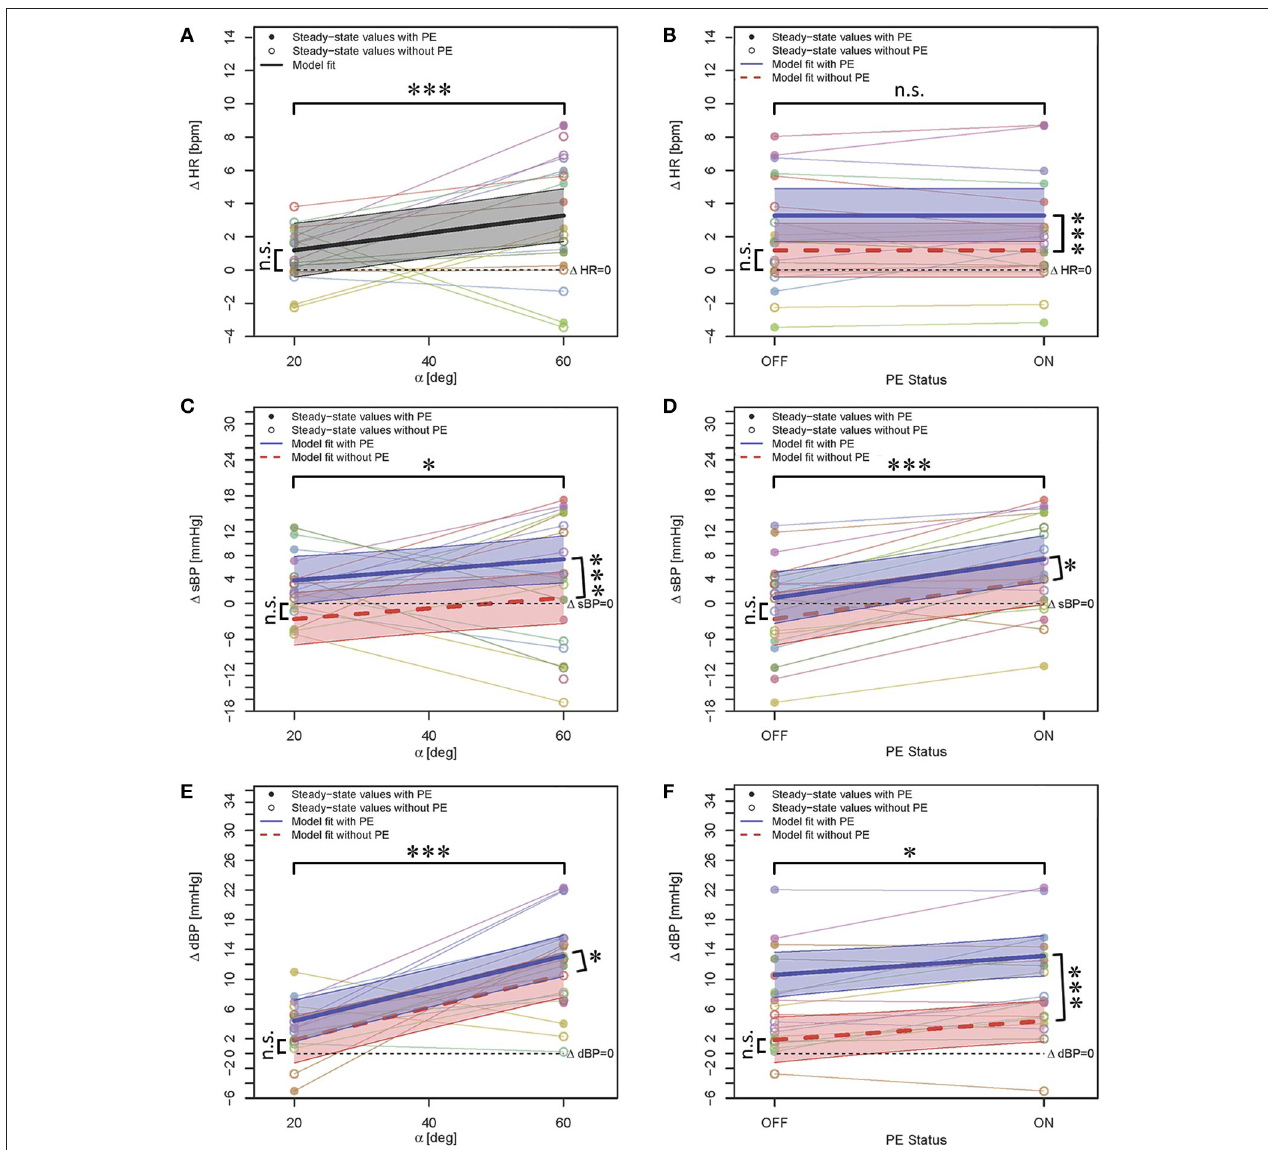
FIGURE 4 | Statistical models for 1 HR (A,B), 1 sBP (C,D) , and 1 dBP (E,F) responses to PE when the effect is considered together with the effect of head-up tilting. In this figure, both columns show the same models with variation with respect to tilt angle (left column) and PE status (right column), respectively. As the PE effect for 1 HR was not significant, Figure 4A , only shows one model for both conditions of with and without PE. Data points correspond to the average of steady-state response on two days. In case of availability of only single case measurement, the data point without averaging is shown. The steady-state values for each subject in each case (PE status or tilt angle) are color-coded and connected with lines. The highlighted areas show 95% CI. The signs * and *** mark significant findings with p ≤ 0.05 and 0.001, respectively. n . s . marks non-significant